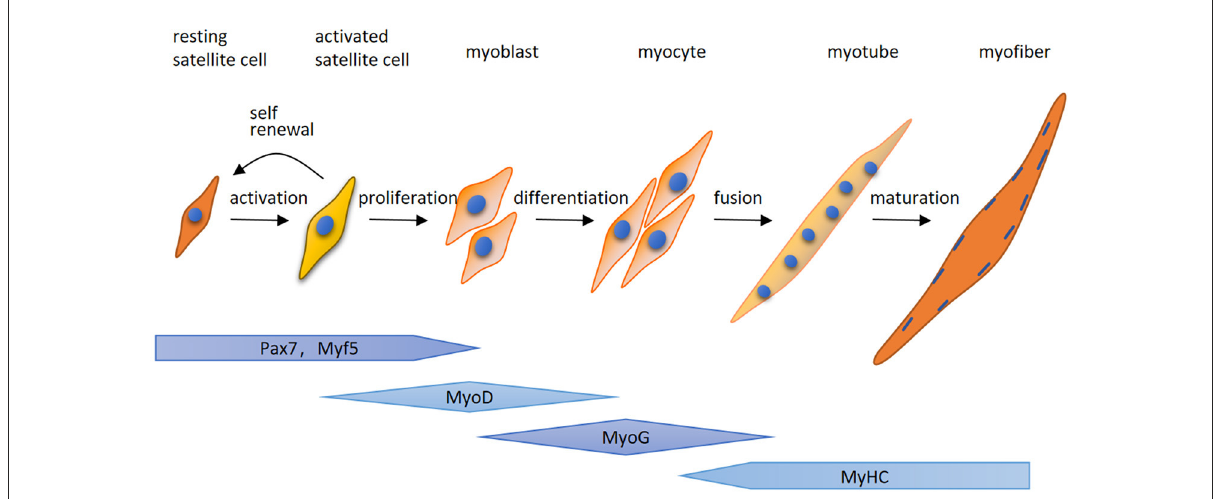
FIGURE5 A schematic illustration of myogenesis. Quiet satellite cells are activated by various stimuli after muscle injury, undergo the proliferative phase and produce adequate myoblasts. After that, myoblasts differentiate into myocytes which fuse together to generate multinucleated myotubes and form mature myofibers. The process of myogenesis is highly controlled by sequential expression of paired box transcription factor paired box 7 (Pax7) and myogenic regulatory factors (MRFs), including myogenic regulatory factor 5 (Myf5), MyoD, myogenin (MyoG) and myosin heavy chain